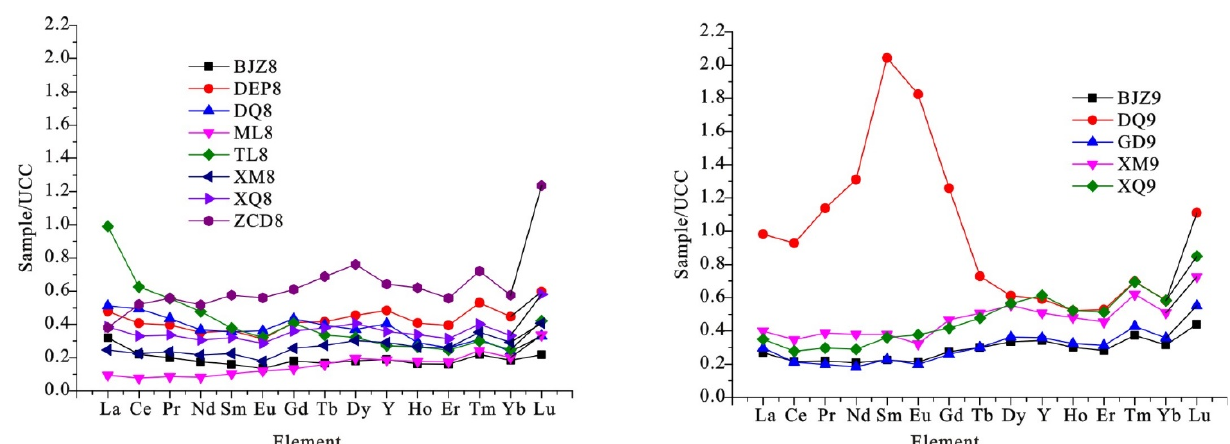
Figure 13. Chondrite-normalized REE patterns of coal samples.